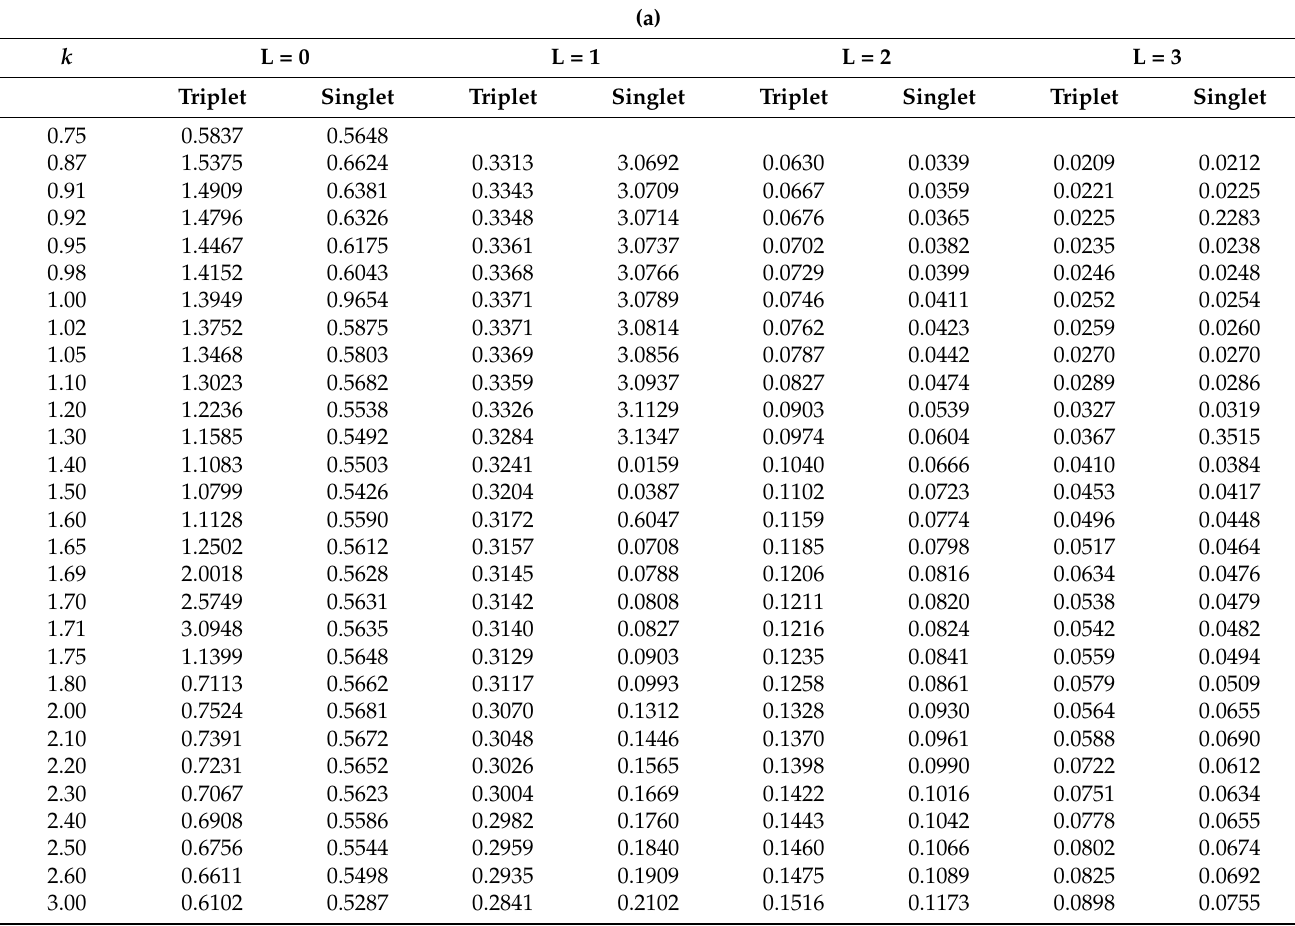
Table 3. ( a ). Phase shifts (radians); ( b ). Phase shifts (10 − 3 radians); ( c ). Phase shifts (10 − 3